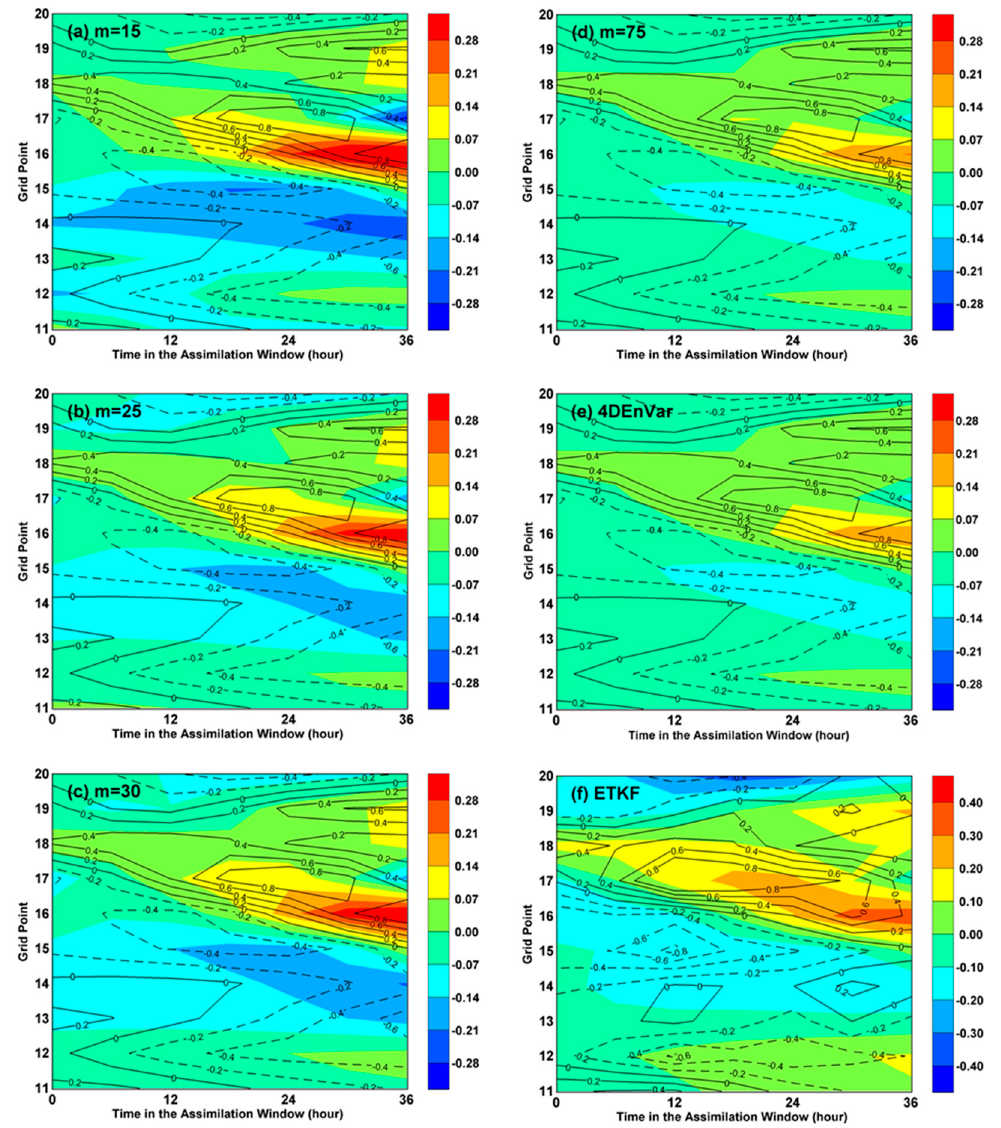
Figure 5. The analysis increments (correction, color shades) and forecast (background) errors (true state minus background mean, contours) of the ETKF, the 4DEnVar, and the DRP-4DVar methods with different m at the grid points 11~20 during the assimilation window on the 1200th model time step. ( a – d ) correspond to the DRP-4DVar method with m as 15, 25, 30, 75, ( e ) correspond to the 4DEnVar method, and ( f ) corresponds to the ETKF. The assimilation window length is 36 h (corresponding to 6 time-step length). The analysis y (cid:48) of DRP-4DVar is generated by linear combination of the basis with different m as Equation (7). As to the DRP-4DVar method with the different m and the 4DEnVar method, the basis vectors and the background errors are computed from the ensemble perturbations from the same original background ensemble during the assimilation window. The original background ensemble is generated by the DRP-4DVar experiment with m = 30 in Exp-1. Meanwhile, since the ETKF sequentially assimilates observations, f employs the analysis y (cid:48) and background error during the 1200–1206 time steps (corresponding to the 36 h assimilation window) of the ETKF experiment in EXP-1. Note that f has an order of magnitude different color scale.